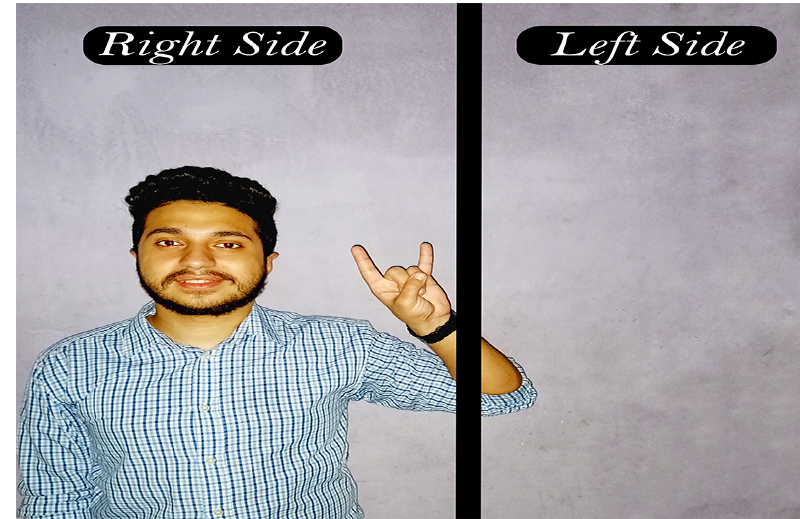
Figure 7. Body on the right-side of the